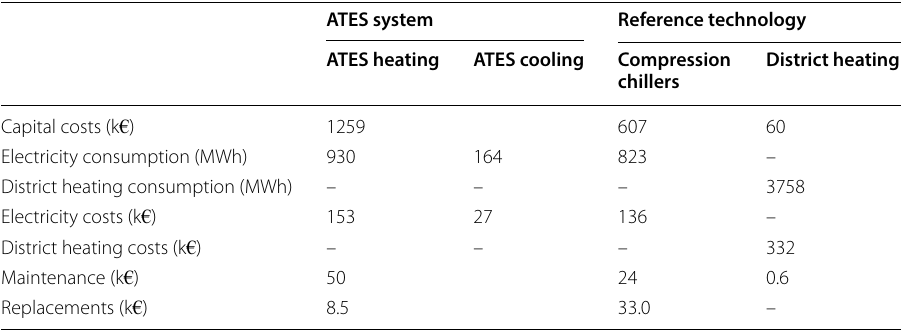
Table 9 Summary of the estimated average capital and current costs and energy consumption of the ATES system and the reference